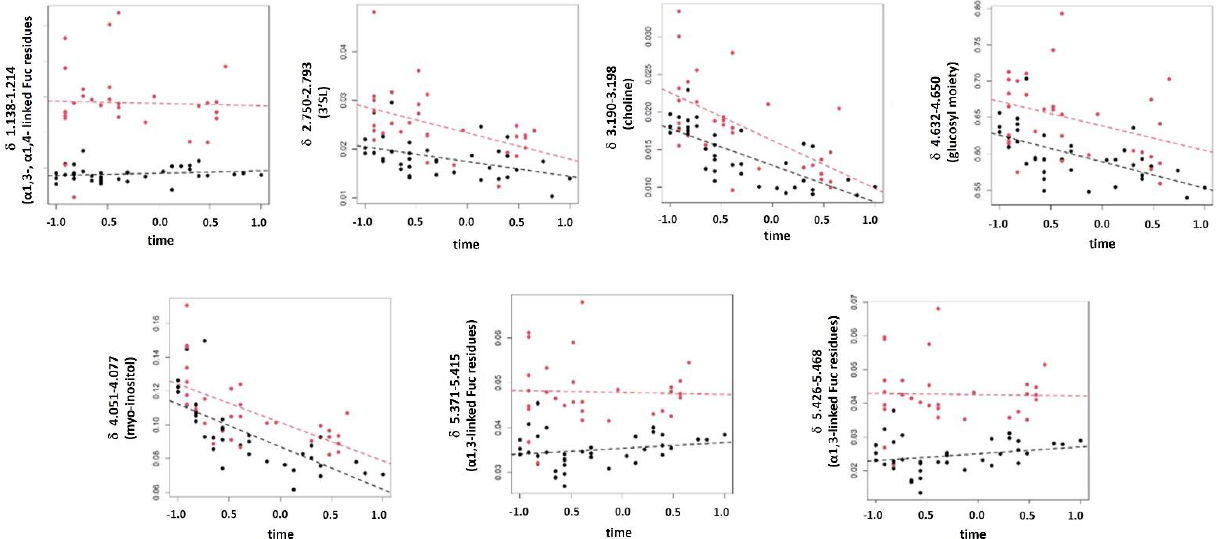
Figure 4. Scatter plots showing the trends of the sum of the fixed effect part and the random error of the LME models considering the seven relevant 1 H NMR annotated signals influenced by the degree of prematurity. Red circles represent samples from mothers delivering moderately preterm, black circles represent samples from mothers delivering extremely preterm, and dashed lines represent the average behavior over time of the two groups.